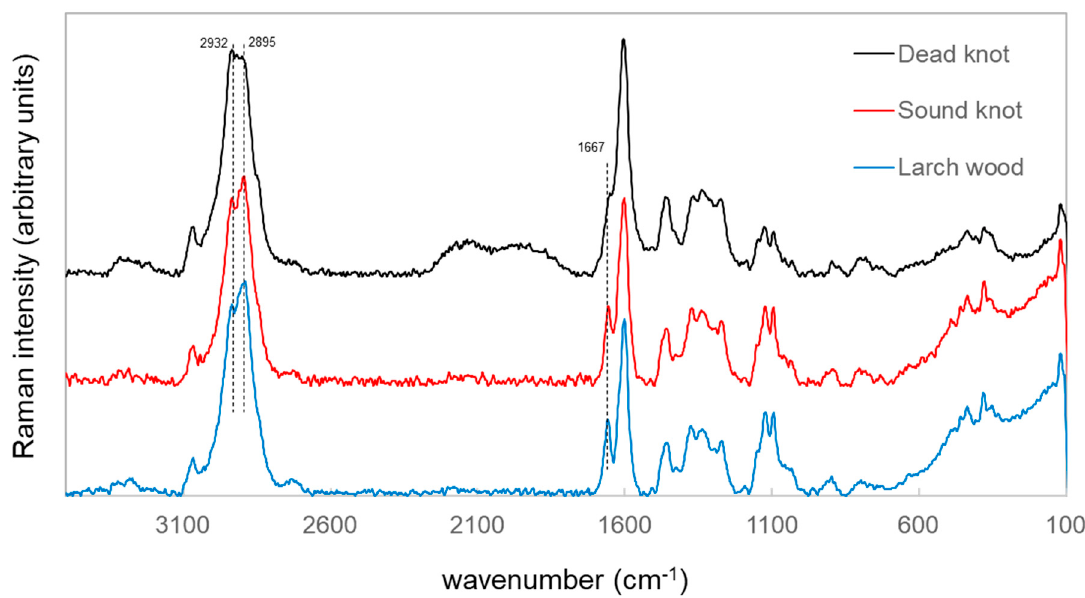
Figure 3. FT-RAMAN spectra of larch wood, sound knotwood and dead knotwood powders, obtained with 1064 nm laser excitation.